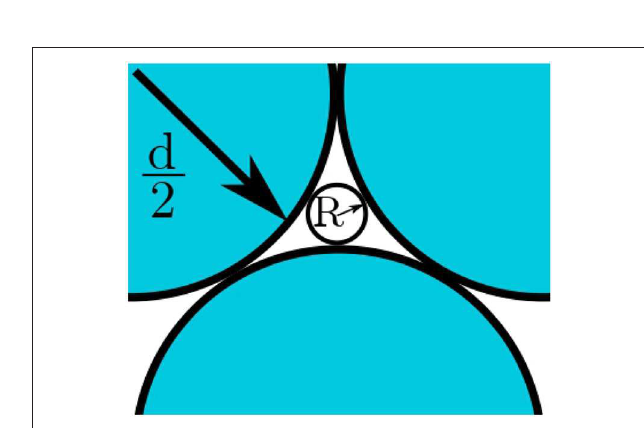
FIGURE 5 | (A) Normalized flow and (B) shear profile for flow in a capillary with an exemplary radius of 1 mm. The fluid is described by the Carreau model using the fitting parameters for the measured rheology. (C) Viscosity distribution µ ( of q profile 3.7 mm/s. =